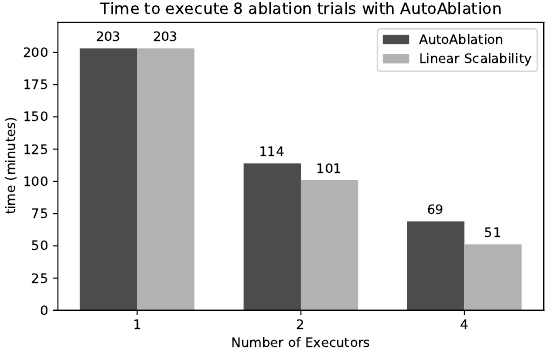
Figure 15. A UTO A BLATION ’s near-linear scalability